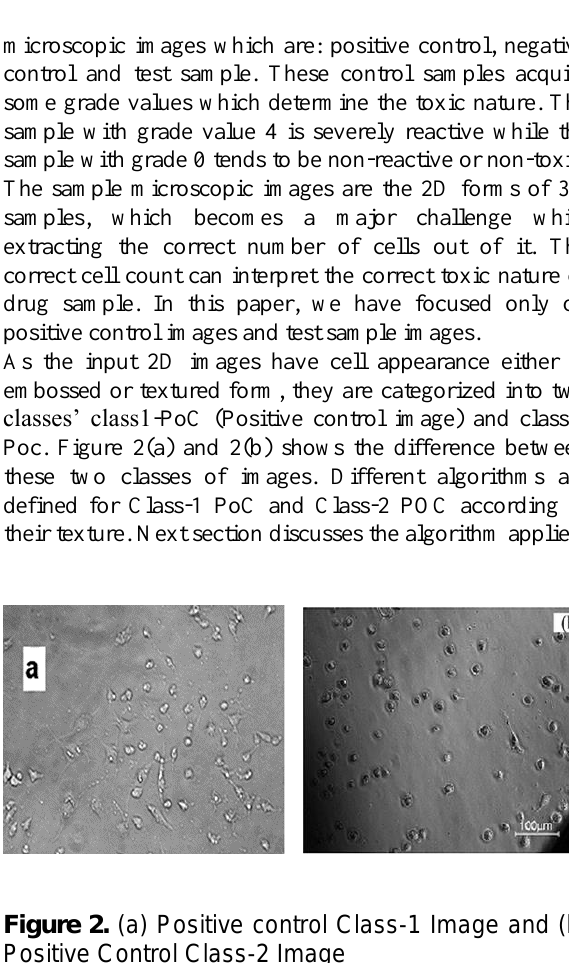
Color Map Transformation: The first step of processing the positive control sample is the linear association of red, blue and green color channel of input image. This transformation is done for the smooth and adaptable processing of image and is based on individual weights associated with each color channel. This resultant brought out image is in grayscale form.